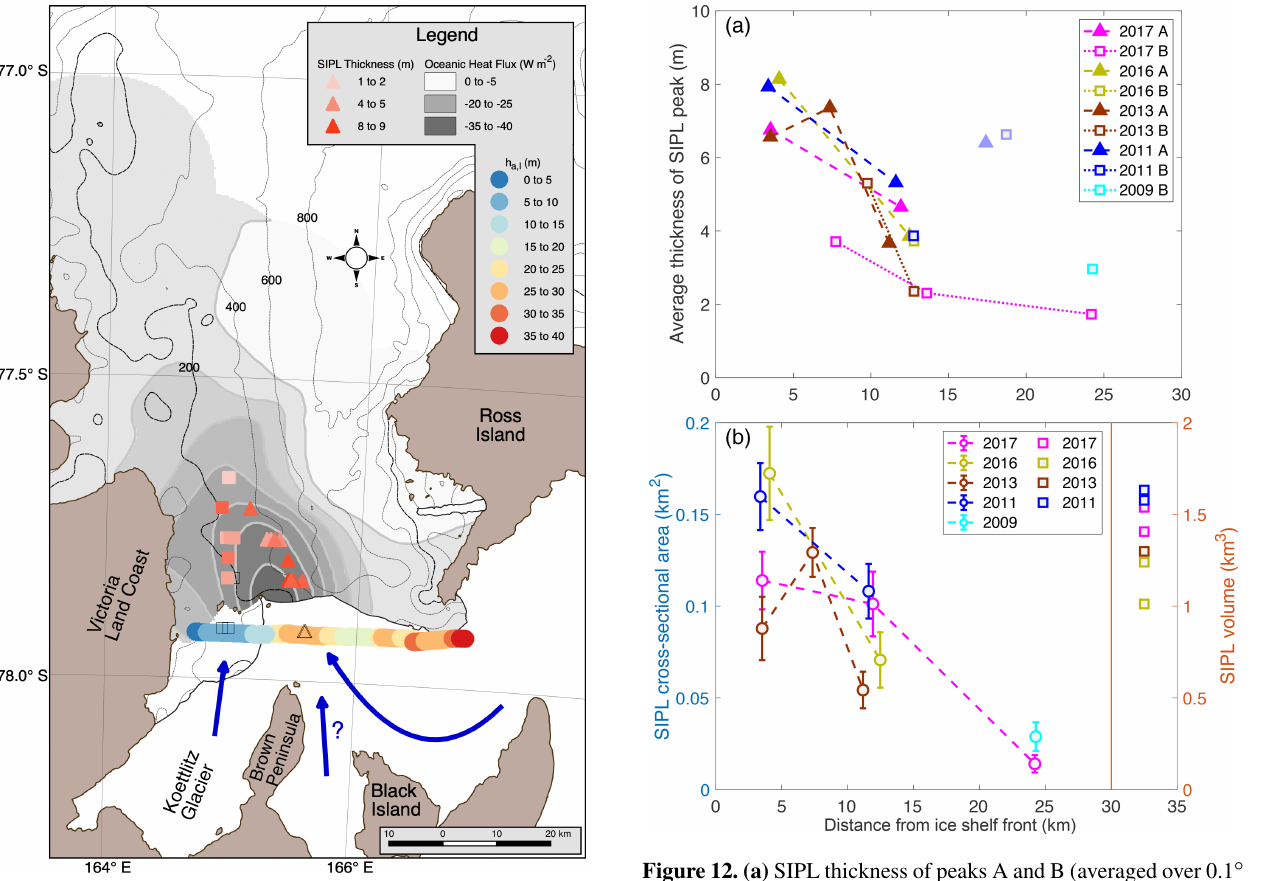
Figure 11. Bathymetric map of McMurdo Sound showing the loca- tion of local maxima in SIPL thickness, with peak A as triangles and B as squares for all years 2009, 2011, 2013, 2016, and 2017. The magnitudes of the local maxima are coloured proportionally to the thickness of the peak, with darker orange for thicker average SIPL. Open symbols denote peaks whose absolute thicknesses were un- certain. Coloured horizontal line shows ice shelf h a ,I profile flown in 2017 with locations of corresponding A and B peaks identified. Contours in grey are proportional to negative ocean heat flux from Langhorne et al. (2015). Blue arrows indicate possible paths of sur- face ISW (based on Robinson et al., 2014).